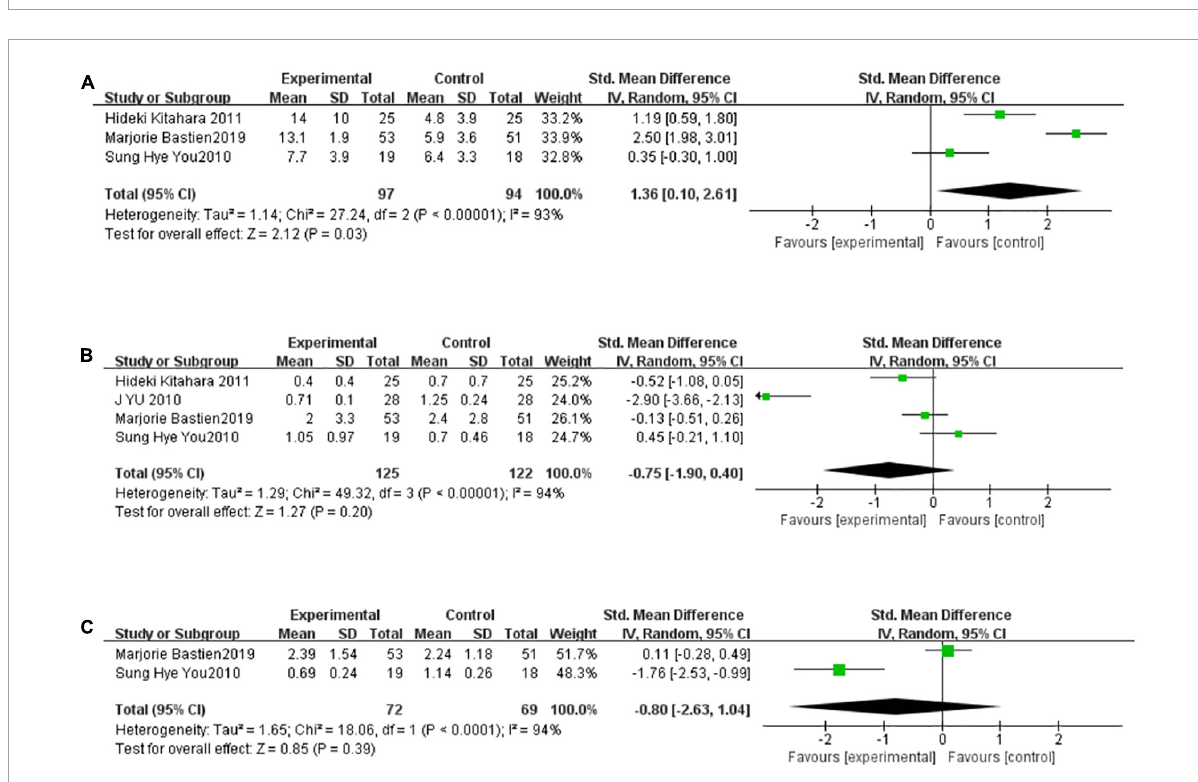
FIGURE4 TZDs increased adiponectin but didn’t affect CRP and IL-6 significantly. (A) Effect of the TZDs on the adiponectin. (B) Effect of the TZDs on the CRP (mg/L). (C) Effect of the TZDs on the IL-6 (ng/L).